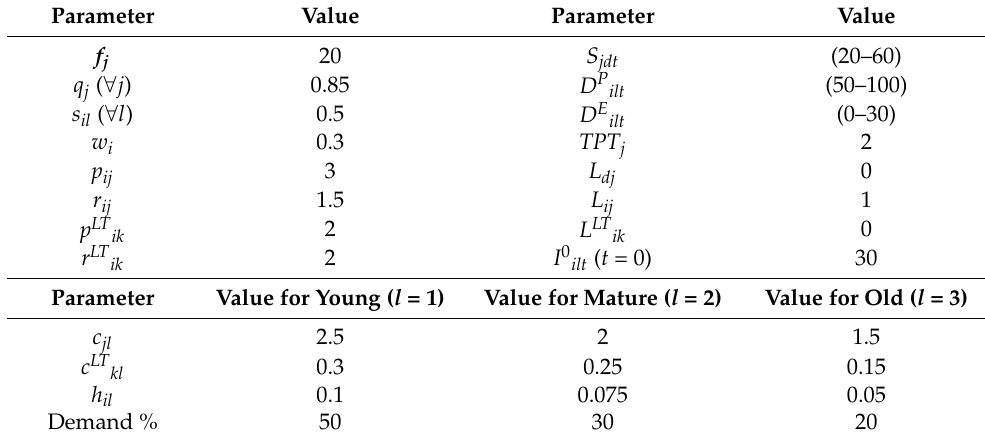
Table 3. Parameters of the BPSCN